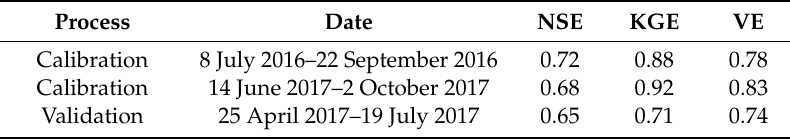
Table A1. Summary of calibration and validation periods and